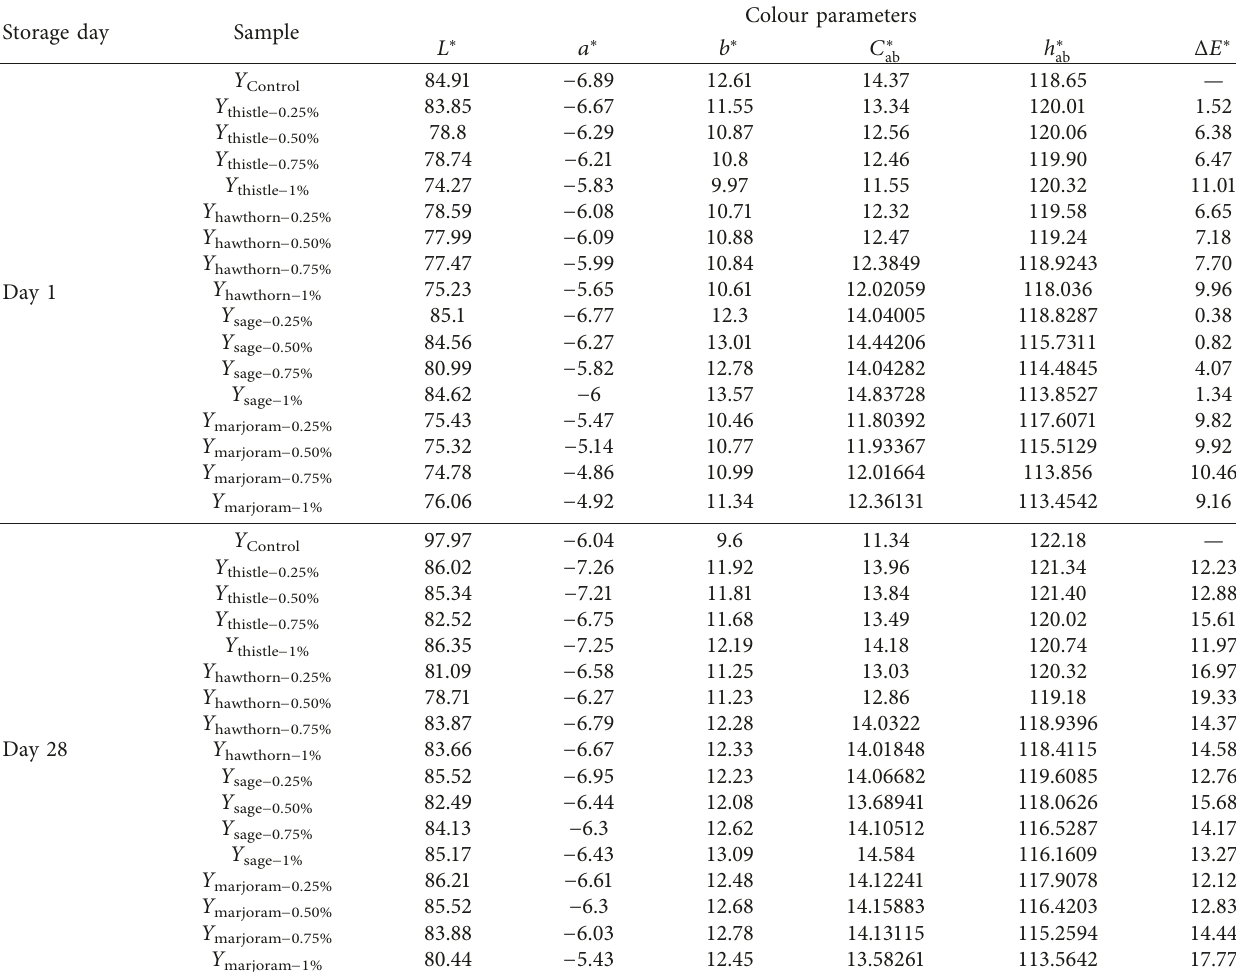
Table 2: Colour parameters of the yogurt with different herb extracts. Storage